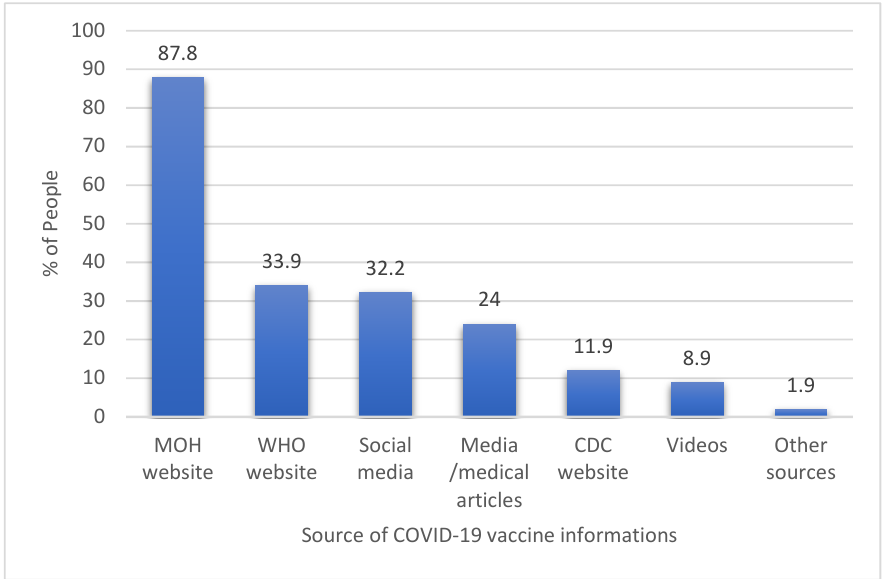
Figure 1. Caregivers’ sources of children’s COVID-19 vaccine information. Table 2. Participants’ COVID-19 perceptions and uptake of the